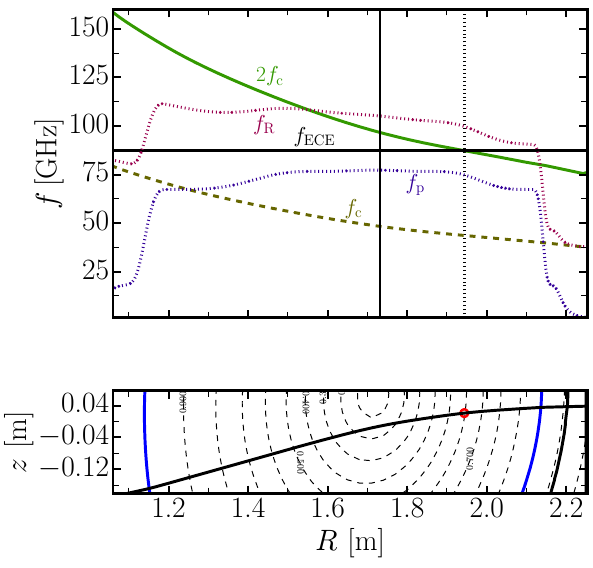
Figure 6. # 32934 at t = 3 . 298s: Radial dependence of the first and second harmonic of the cyclotron frequency f c , the plasma frequency f p , the right hand cut-o ff frequency f R and a measure- ment frequency of 86GHz. The solid vertical line indicates the position of the magnetic axis. The bottom plot shows the cal- culated Ordinary mode (O-mode) ray propagation for f ECE = 86GHz in the (R,z)